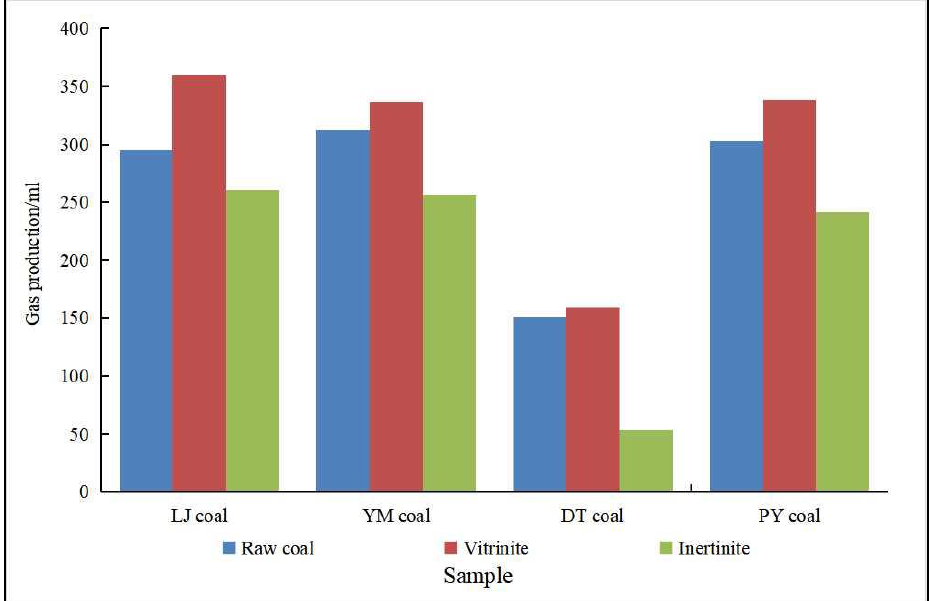
Figure 3. Relationship between maceral and gas production (Adapted from [80,81]). (The coal samples of LiangJia coal mines, YiMa coal mines, DaTong coal mines and PanYi coal mines are abbreviated as LJ coal, YM coal, DT coal, and PY coal, respectively, in Figure).